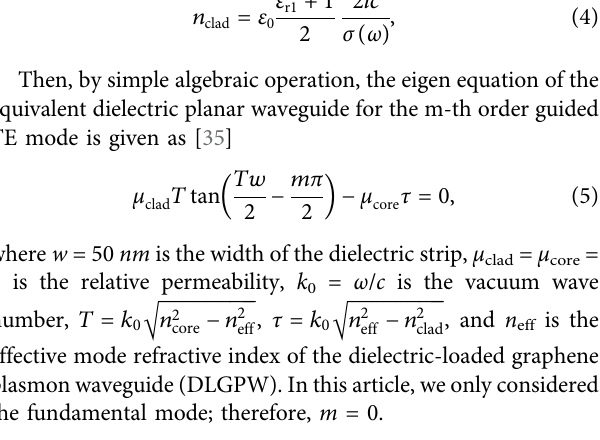
Frontiers in Physics |